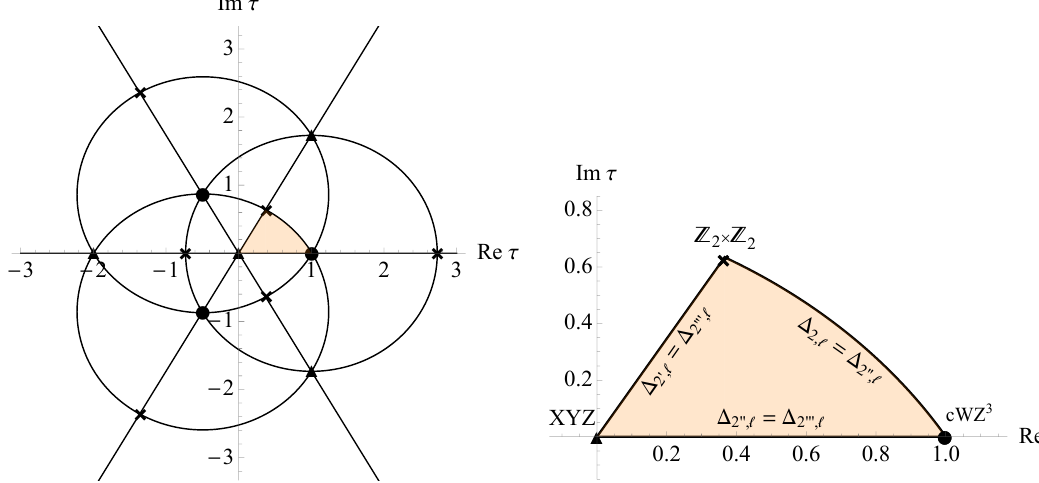
Figure 1 . The black lines denote the images of the real line Im (cid:28) = 0 under the various dualities, and therefore each of them is invariant under an appropriate Z 2 re(cid:13)ection subgroup of the duality group. Each cell de(cid:12)nes a fundamental domain, and the orange shading is the domain we chose in (2.17). The triangles, circles, and crosses are dual to the XYZ, cWZ 3 , and Z 2 (cid:2) Z 2 theories p with (cid:28) = 0 ; 1 and (1 (cid:0) 3) ! 2 , which are self-dual under the S 3 , S 3 , and Z 2 (cid:2) Z 2 subgroups of S 4 de(cid:12)ned in (2.18). There is an extra circle at (cid:28) = 1 . The plot on the right is focused on